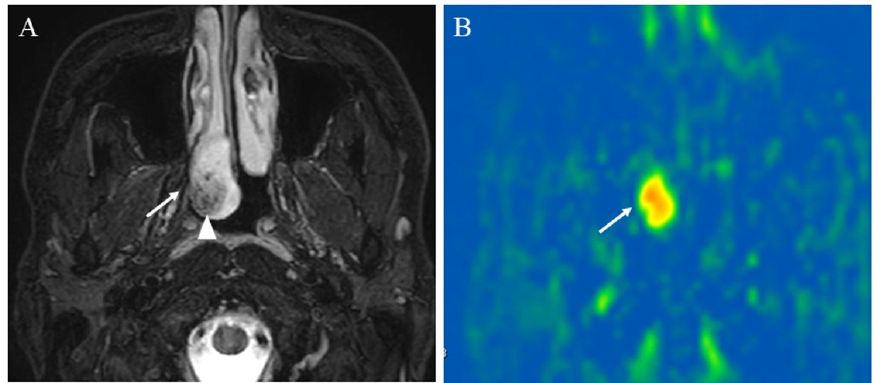
Figure 8. A 23-year-old male with juvenile nasopharyngeal angiofibroma: ( A ) STIR shows a mass with high signal intensity (arrow) and subtle flow voids within the mass (arrowhead); ( B ) pCASL image shows markedly elevated blood flow within the lesion (arrow) (mean of 380.42 mL/100 g/min).